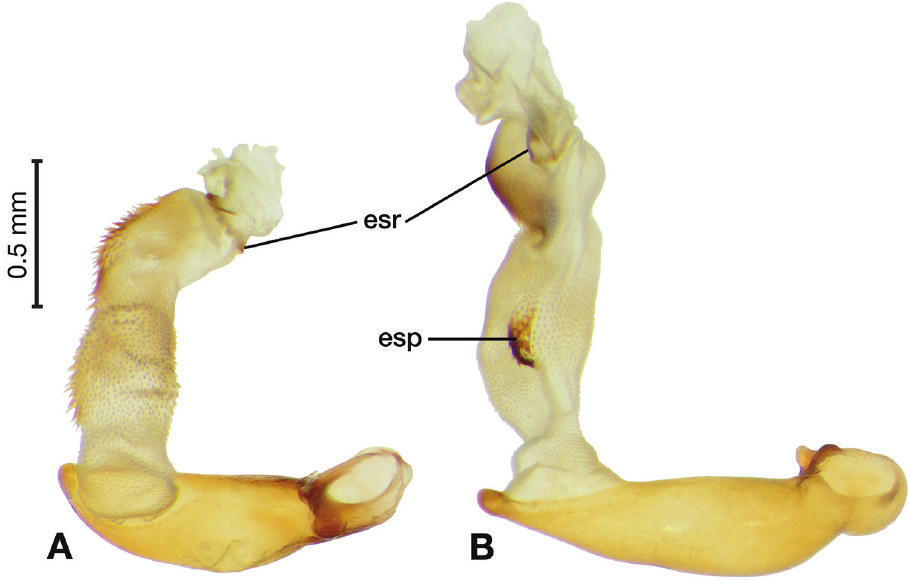
Figure 46. Digital images comparing the everted endophallus characteristics, left lateral aspect, of A C. ( Coptoderina ) maculata (Dupuis) B C. ( Coptoderina ) marginata (Dupuis) Legend: esp endophallic spine patch; esr endophallus sclerite